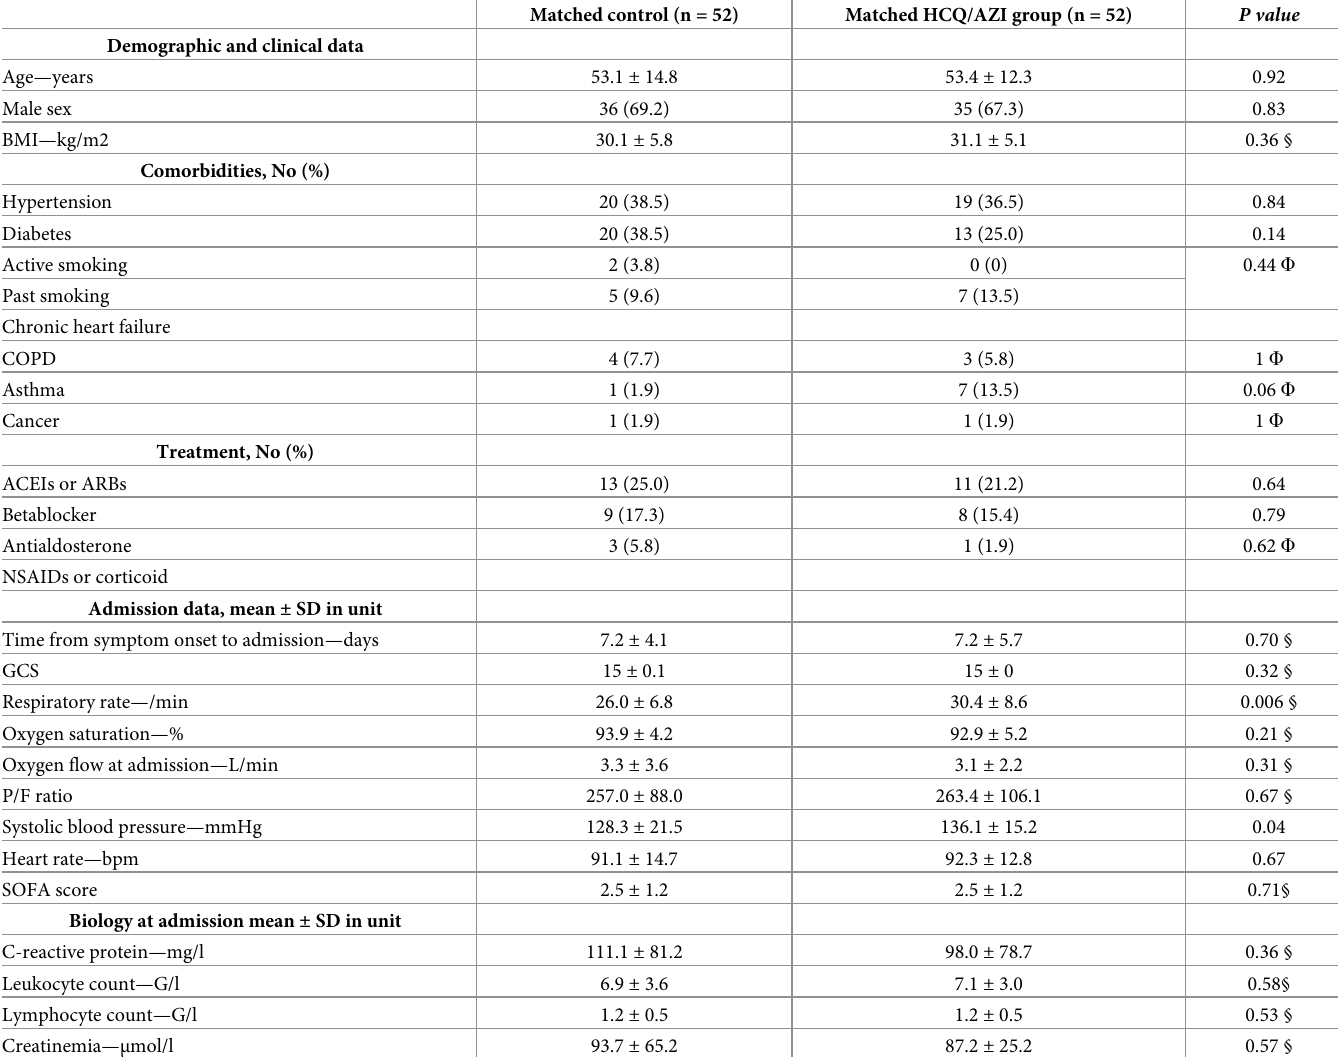
Table 2. Demographic and clinical characteristics of matched cohort patients. Unless noted otherwise, parametric comparisons were